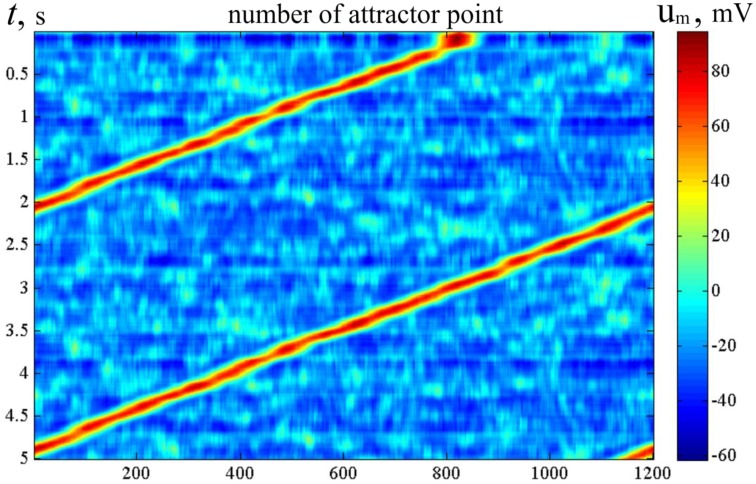
Raster of activity for LIF bump attractor. Horizontal line—order number of the molecular markers. Vertical—time (s), from top to bottom. The color of the dots codes the sum of membrane potentials of the neurons, which contains markers with order markers from [x−L∕2] to [x + L∕2], x = 1, …, M. LIF neural network with accommodation (Supplementary Material A1.3), τCa = 0.1c, N = 600, M = 1200, L = 30. The figure looks like Figure 6. Alike the latter, it means, that the neural network activity of the neural network with one-dimensional attractor “rolls over” the candidate states in course of artificial dynamics (in this case, due to Ca++ entering into the neuron in connection with excitation impulses). The difference between Figure 4 and this figure is in the criterion of activity presence in a particular state (see the text for detail).